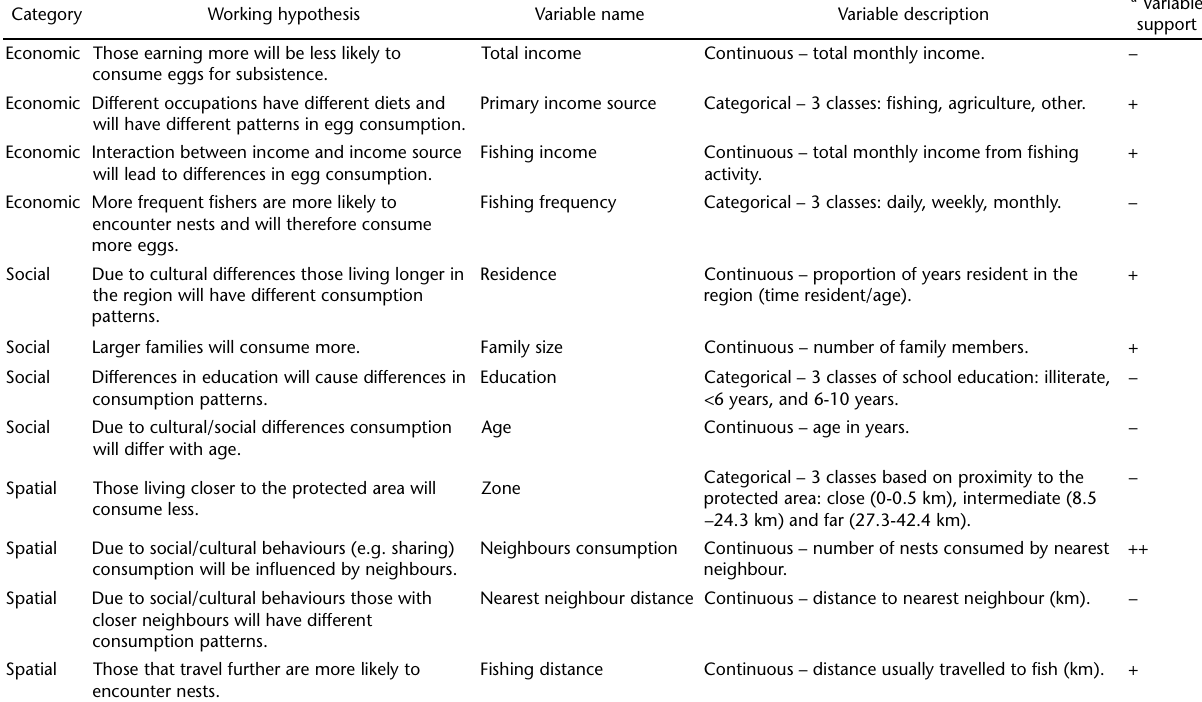
Table I. Working hypotheses and variables used to explain consumption of P . unifilis eggs by ribeirinhos in the eastern Brazilian Amazon.